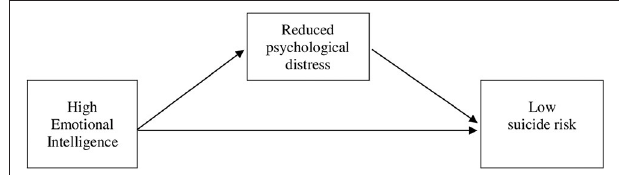
FIGURE 1 | Proposed model of the role of psychological distress in explaining the relationship between emotional intelligence to suicide risk.